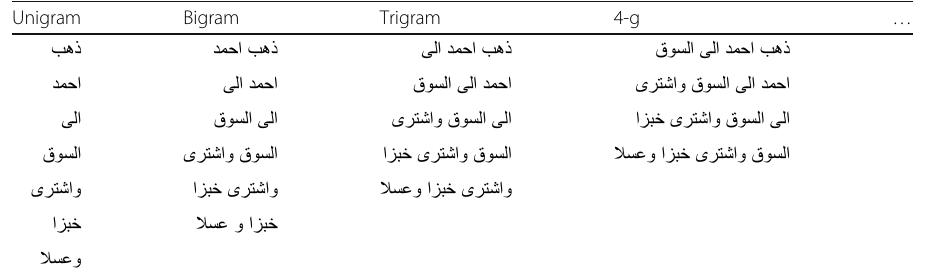
Table 4 N-gram segments generated from a sentence